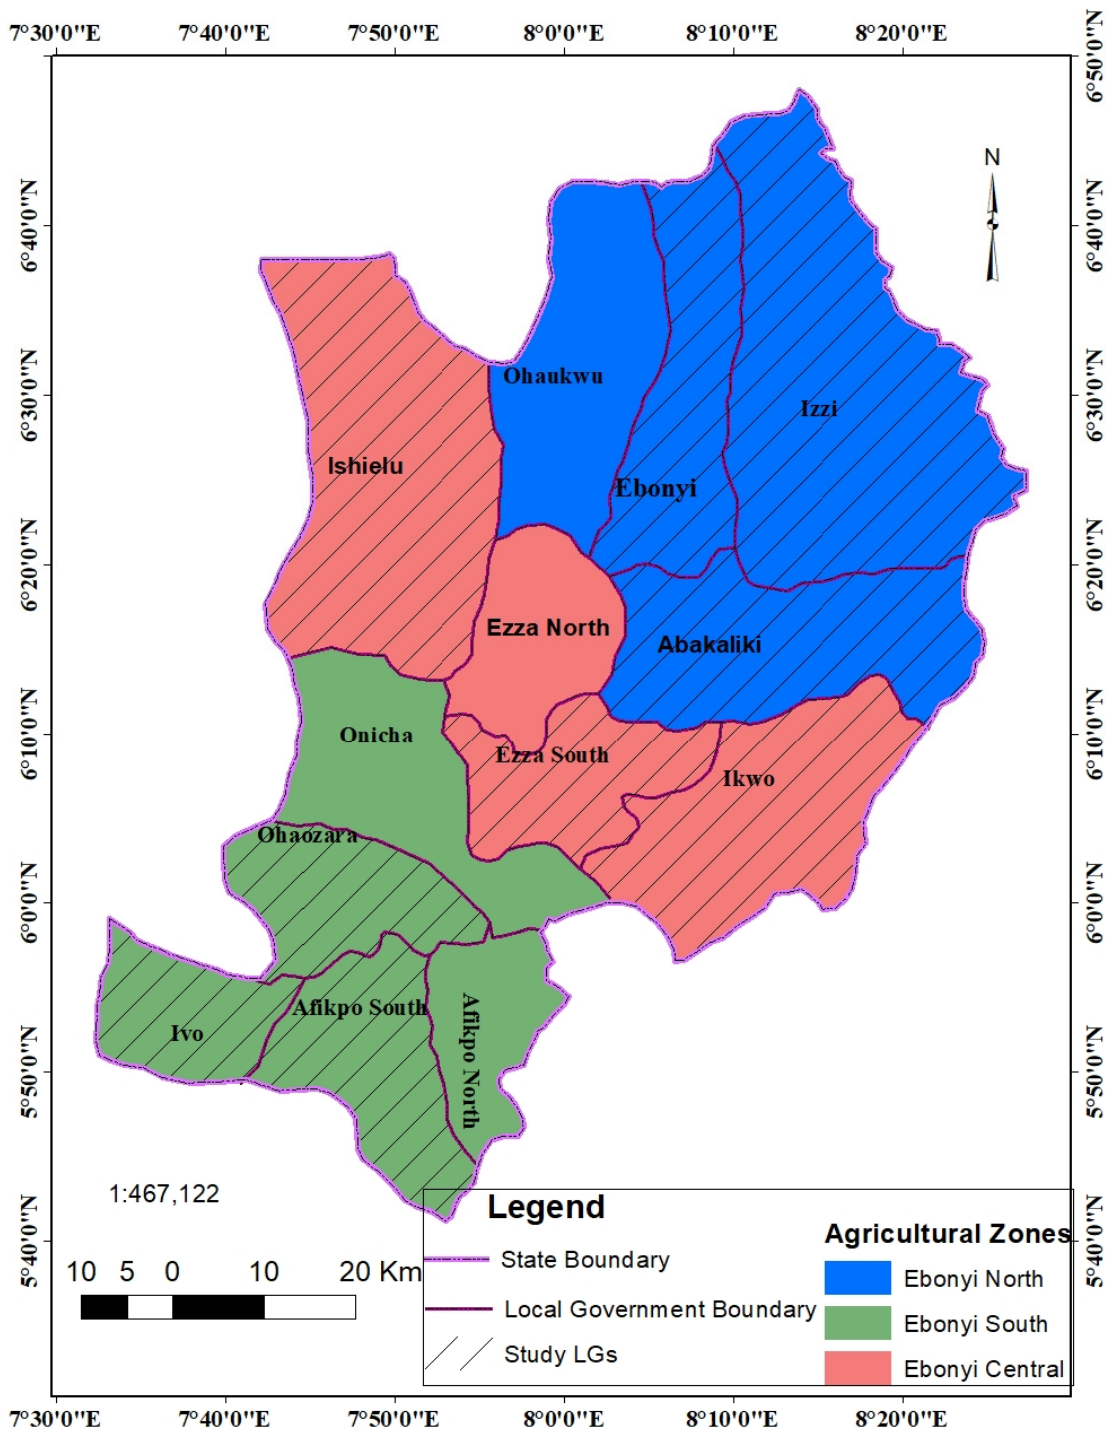
Figure 1. Map of Ebonyi State showing the LGAs.